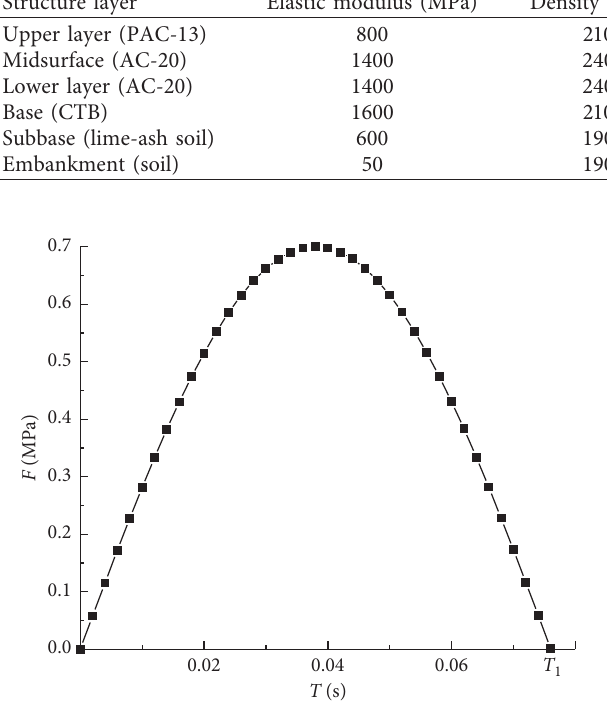
Figure 7: Loading curve of wheel load.